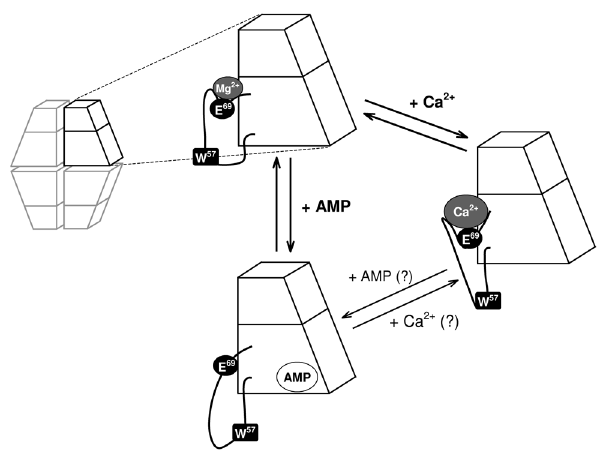
Figure 5. The effect of Mg 2 + , Ca 2 + and AMP on the conforma- tion of loop 52–72. Magnesium cations bind and/or stabilize the engaged form of loop 52–72 of FBPase, whereas association of AMP induces changes leading to the disengaged form of the loop. Ca 2 + competes with Mg 2 + for the same binding site and stabilizes an inactive disengaged-like conformation of loop 52–72. It is unclear whether Ca 2 + may bind to the enzyme which is saturated with AMP and vice versa .